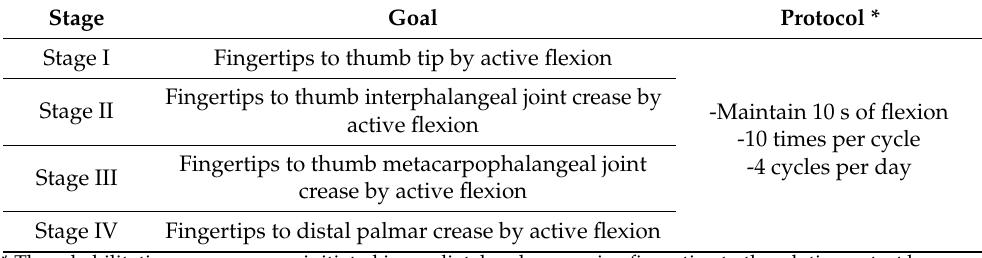
Table 2. Postoperative rehabilitation protocol for multiple metacarpal fractures in our institution. Stage Goal Protocol